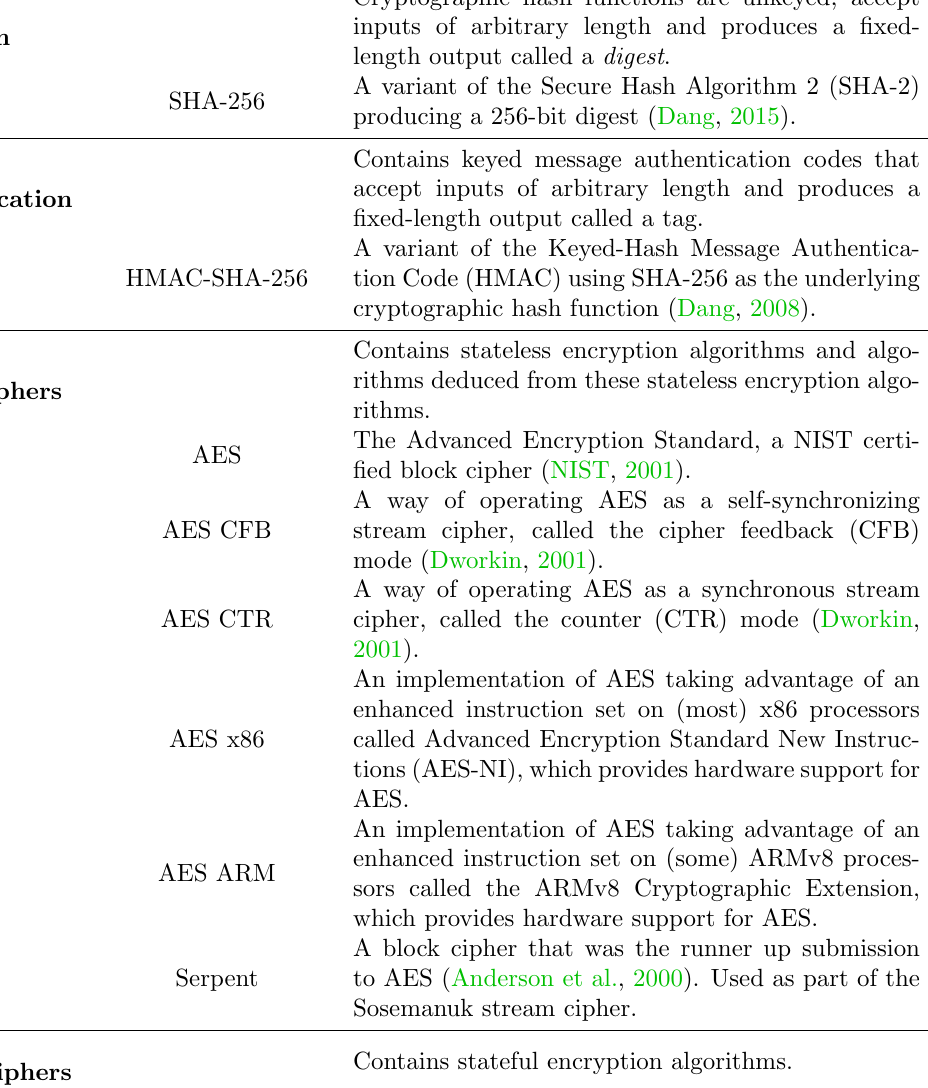
Table 1: An explanation of the contents of the